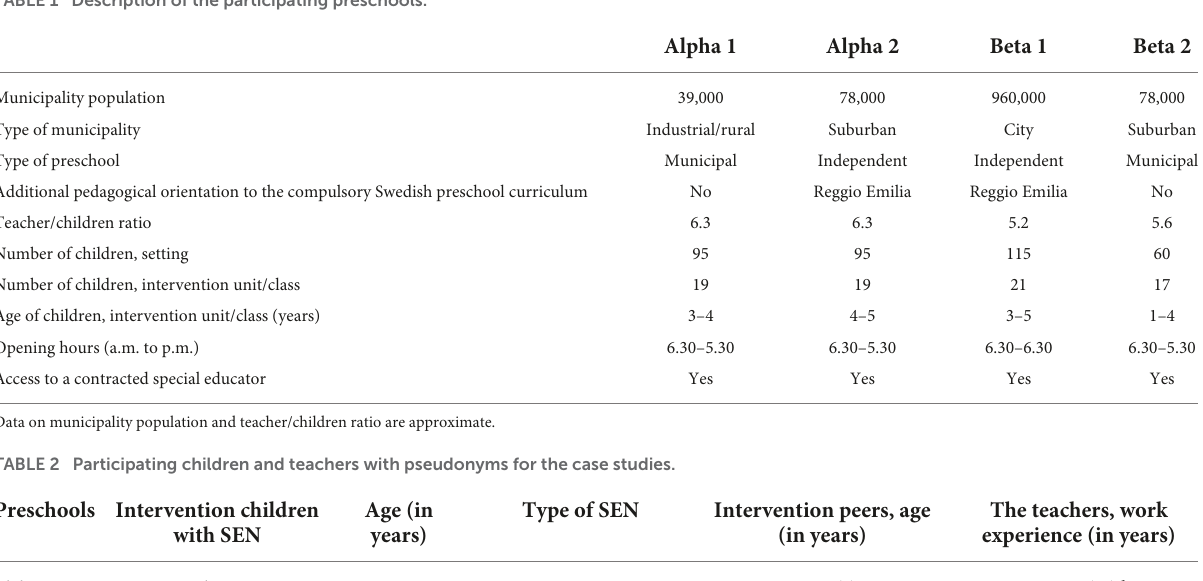
TABLE 1 Description of the participating preschools.